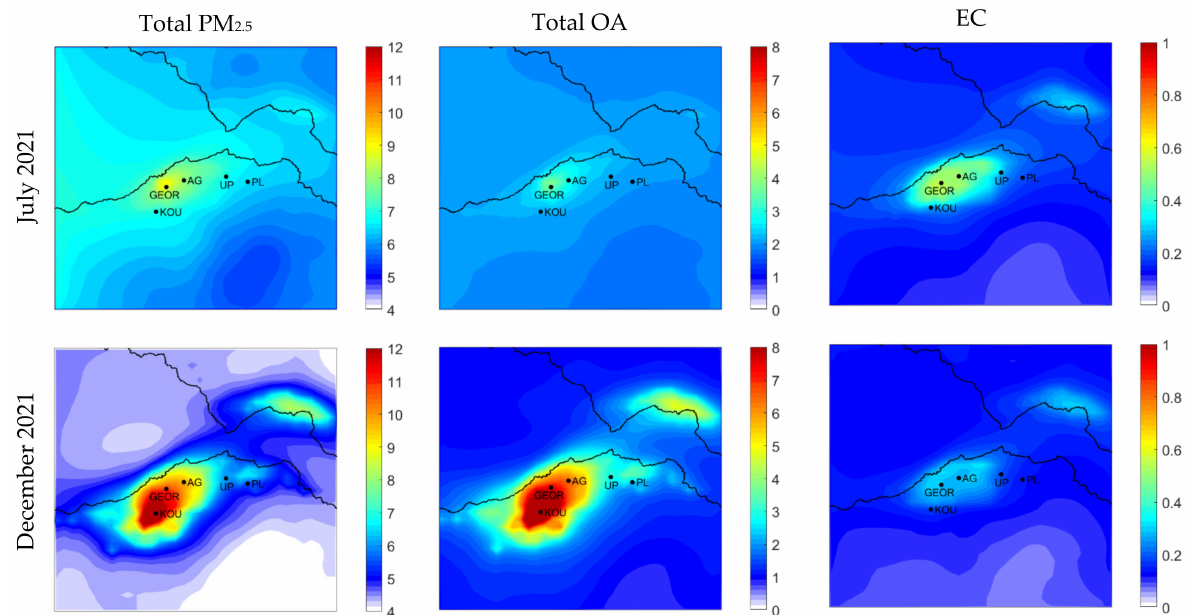
Figure 5. Predicted average ground concentrations ( µ g m − 3 ) of total PM 2.5 , total fine OA and fine elemental carbon (EC) during July and December 2021 for the inner domain including Patras at 1 × 1 km 2 resolution. Different scales are used.